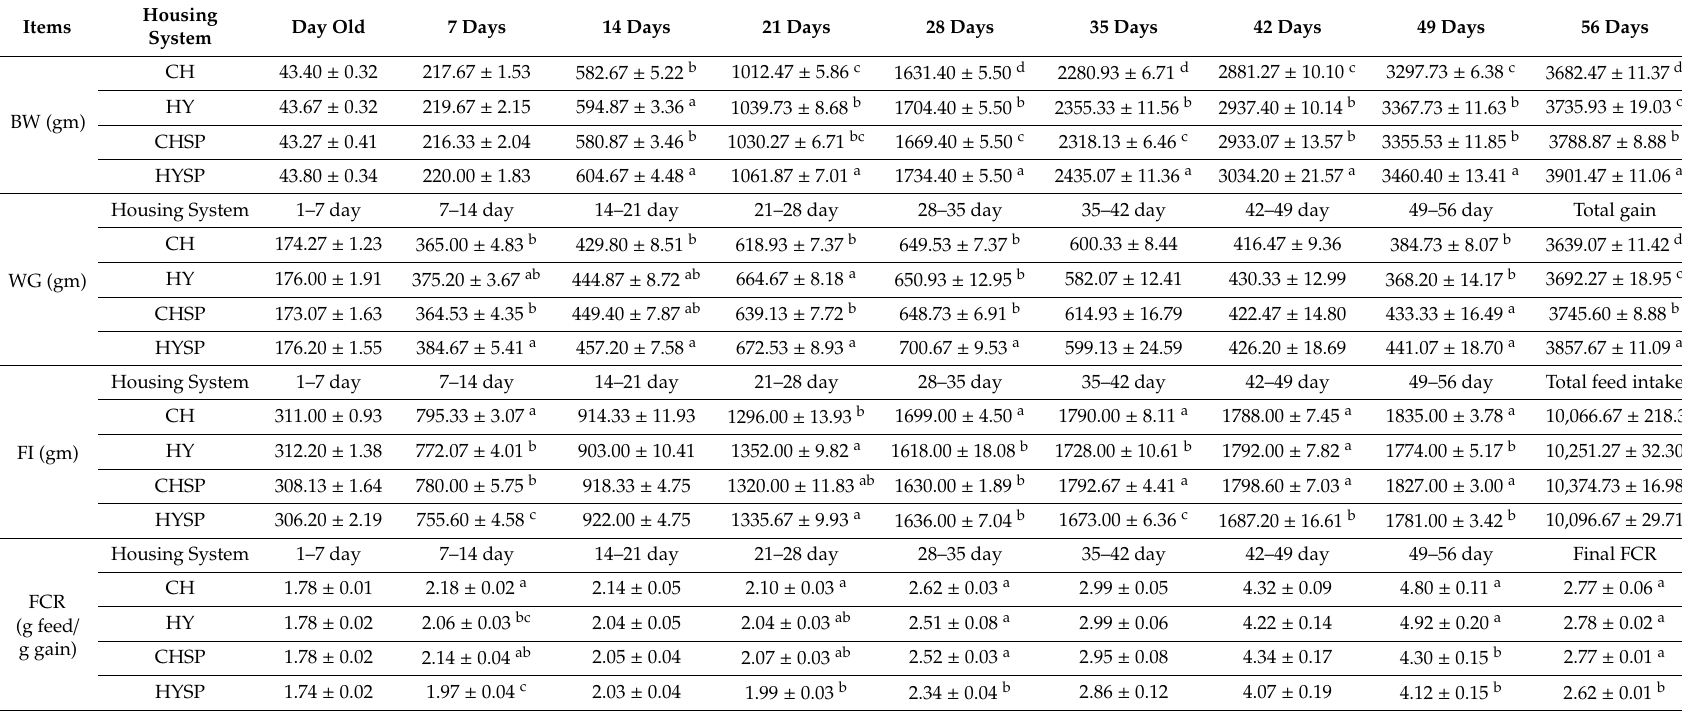
Table 1. E ff ect of di ff erent housing systems on the productive performance of Pekin